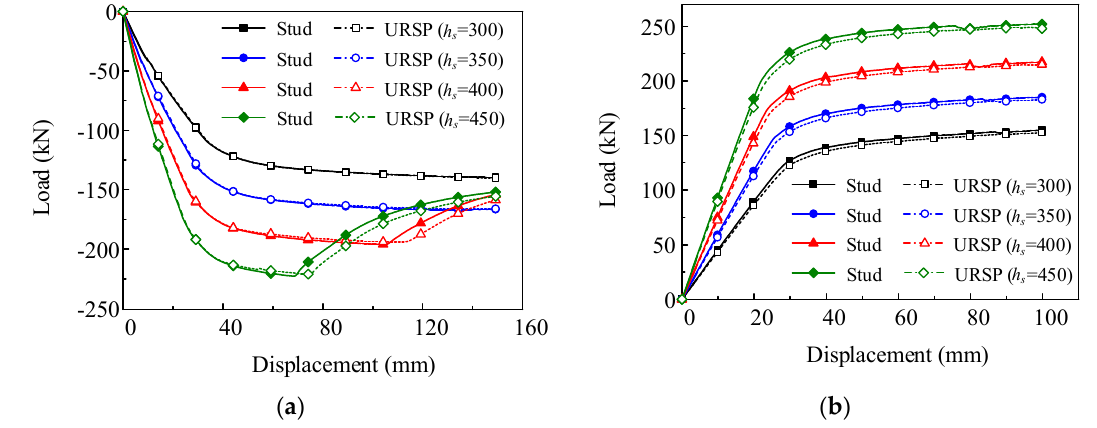
Figure 16. Load-displacement curves with different steel beam heights h s . ( a ) Hogging moment; ( b ) sagging moment.